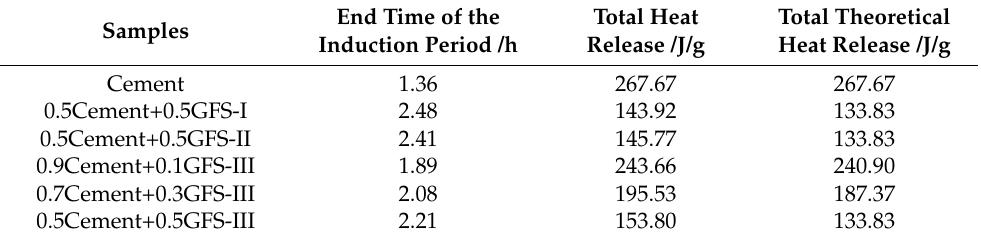
Figure 8. Hydration heat release rate ( a ) and cumulative hydration heat ( b ) of the different cement pastes. Table 3. Hydration characteristics and cumulative heats of different cement